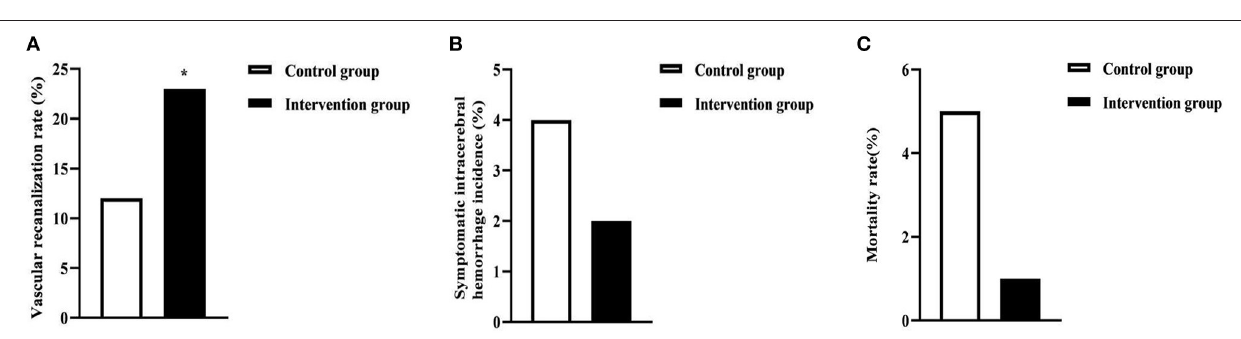
FIGURE 3 | Clinical outcome indicators in the two groups of patients. (A) was the vascular recanalization rate. (B) was the symptomatic intracerebral hemorrhage incidence. (C) was the mortality rate. * was the comparison of similar items between groups, P < 0.05.